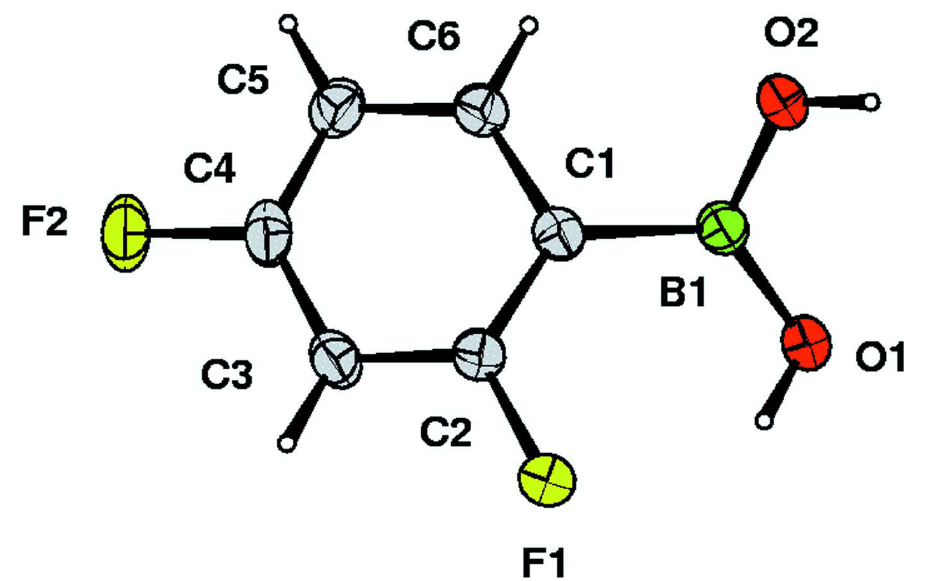
Figure 1 The molecular structure of (I) with displacement ellipsoids drawn at the 30% probability level and H atoms shown as small spheres of arbitrary